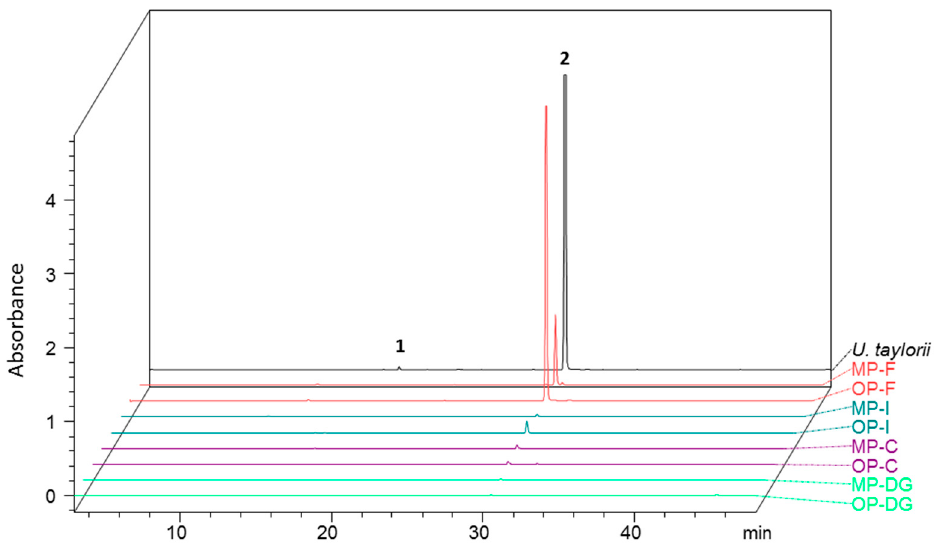
Figure 4. PDA chromatogram at 290 nm of acetone extracts of N. hookeri digestive gland (DG, green curves), crops (C, purple curves), intestines (I, blue curves), and feces (F, red curves) after being fed with U. taylorii (black curve). These profiles are compared according to their phenotype (MP = mineral, PBAS sample; OP = organic, MAS sample).